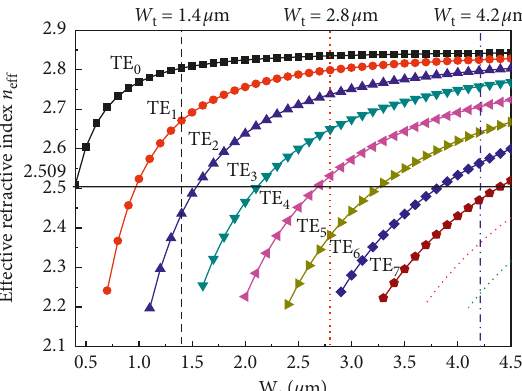
Figure 5: The effective refractive index of the distributed state of eight TE modes with the width of a linear tapered waveguide is ranging from 0.4 μ m to 4.5 μ m. The effective refractive index n eff of the slab waveguide on an SOI chip is 2.509 and the thickness of this linear tapered waveguide h co is 220nm at an operating wavelength of 1550nm.